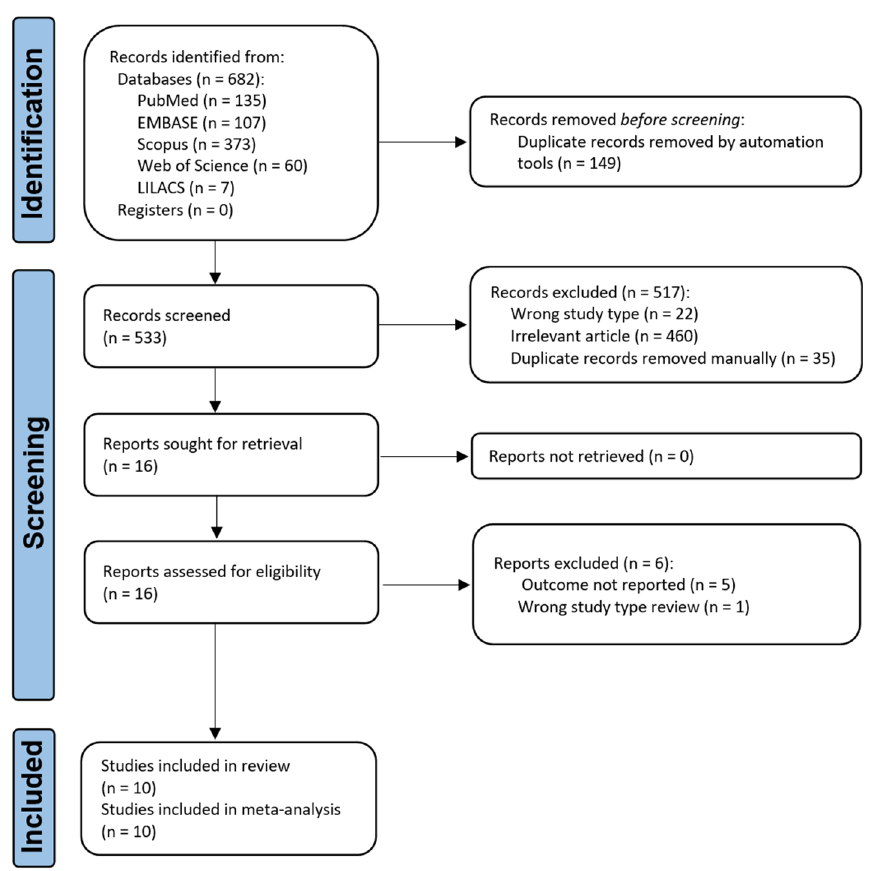
Figure 1. Flow diagram of the literature search and selection criteria adapted for PRISMA 2020.